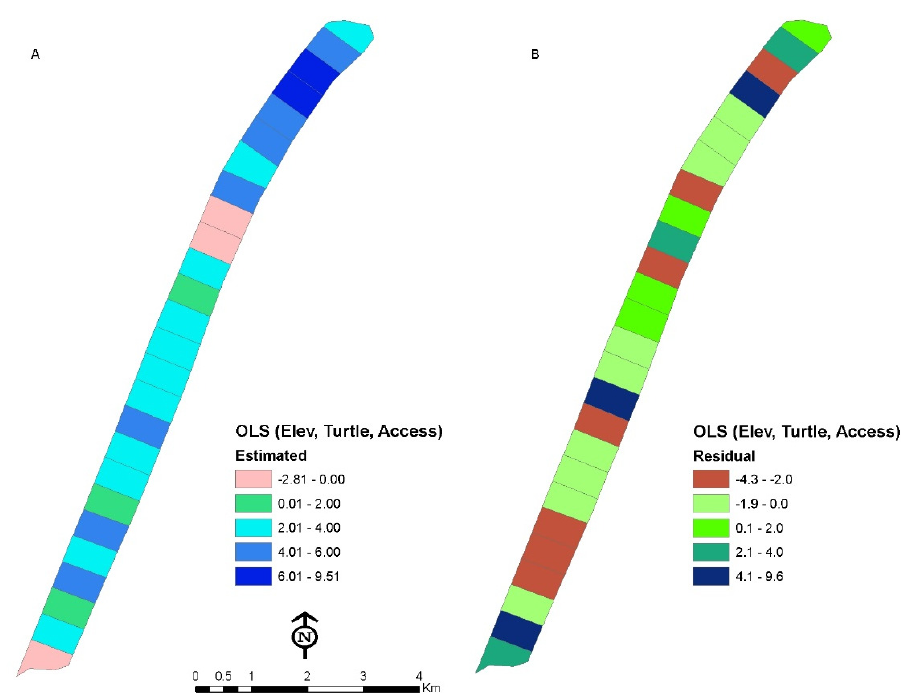
Figure 9. Ordinary Least Square regression analysis where ( A ) is the predicted number of fox den entrances and ( B ) is the distribution of residuals (predicted den entrances minus observed den entrances).